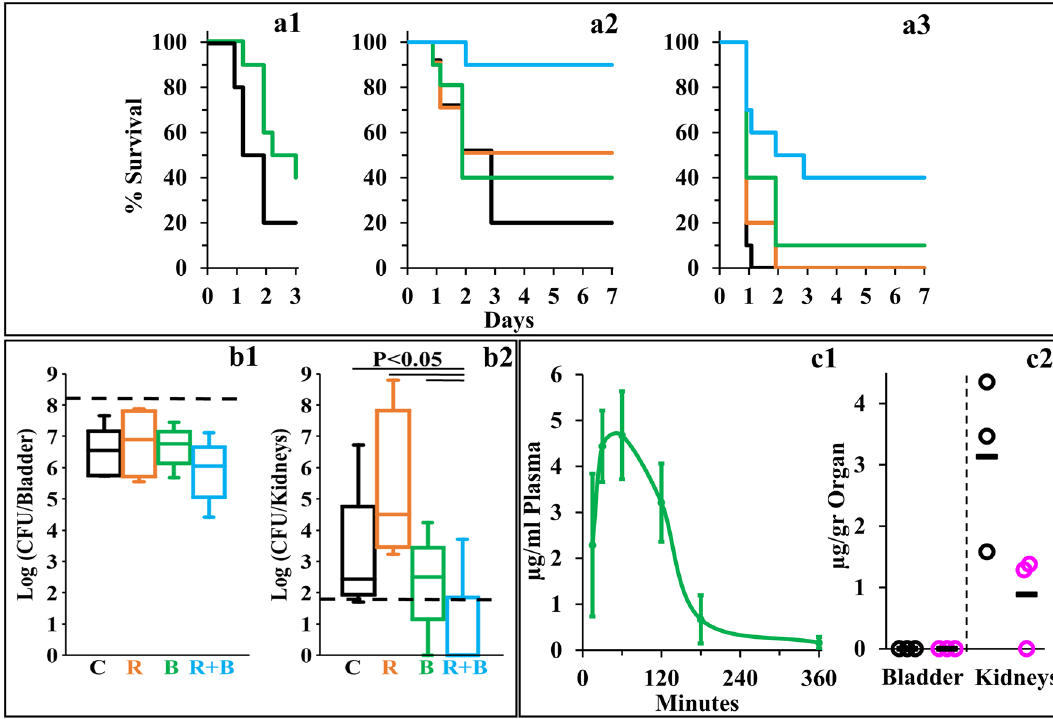
Figure 3. C 10 BBc 12 B Properties in Mice Models. ( a ) Percent survival of neutropenic mice (n = 10 per group) infected with E. coli 25922 using the peritonitis-sepsis infection model. Panel a1 shows survival rates of mice infected with 1.4 × 10 6 CFU/mouse using a modified model, in which bacteria were pre-treated in-vitro for 15 min with 10 µM C 10 BBc 12 B. Bacteria pre-treated with the vehicle control, black; bacteria pre-treated with C 10 BBc 12 B, green. Panels a2 and a3 respectively show representative survival rates of mice infected with 1.7 × 10 6 and 1.9 × 10 6 CFU/mouse. Vehicle treated control, black; 20 mg/kg rifampin, orange; 12.5 mg/kg C 10 BBc 12 B, green; rifampin + C 10 BBc 12 B, cyan. ( b ) Organs bacterial loads in mice (n = 5 per group) infected with 1.2 × 10 8 CFU/mouse of UPEC CFT073 using the urinary-tract infection model. Box plots in panels b1 and b2 respectively show the CFU counts assessed 24 h post-infection for bladders and kidneys. Vehicle treated control (C) black; 2 mg/kg rifampin (R) orange; 7.5 mg/kg q.i.d. C 10 BBc 12 B (B), green; rifampin + C 10 BBc 12 B (R + B) cyan. Upper and lower dashed lines respectively represent the inoculum and the limit of detection. ( c ) Quantification of C 10 BBc 12 B in organs of interest, as determined following S.C. administration of 12.5 mg/kg to mice (n = 3 per time point). Panel c1 shows C 10 BBc 12 B circulating concentrations in mice plasma. Error bars represent standard deviations. Panel c2 shows the levels detected in mice bladder and kidneys. t = 1 h, black circles; t = 3 h, pink circles; averages, black horizontal